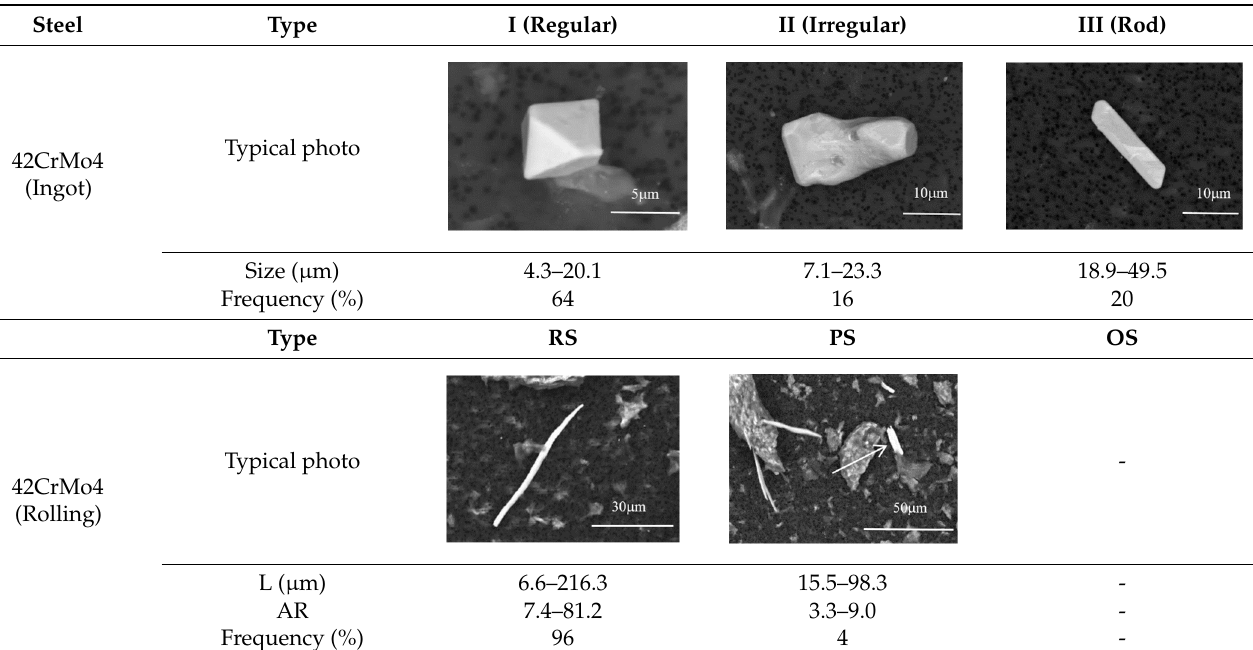
Table 8. Typical SEM images of MnS inclusions in an ingot sample and a rolled steel samples after heat treatment when using Method 1.